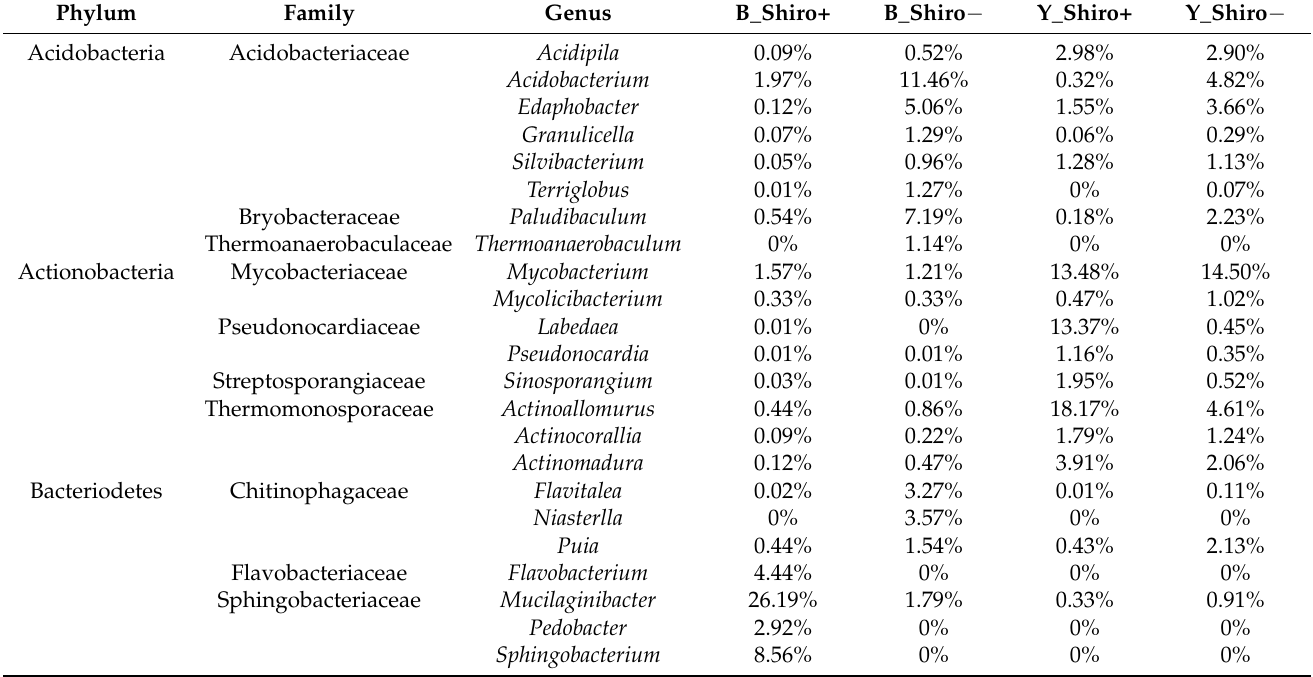
Table 4. List of bacterial genera inhabiting the Tricholoma matsutake production (shiro+) and nonproduction (shiro − ) soils of Bonghwa and Yangyang sampling sites. The bacterial genera present more than 1% of at least one sample among the four soil